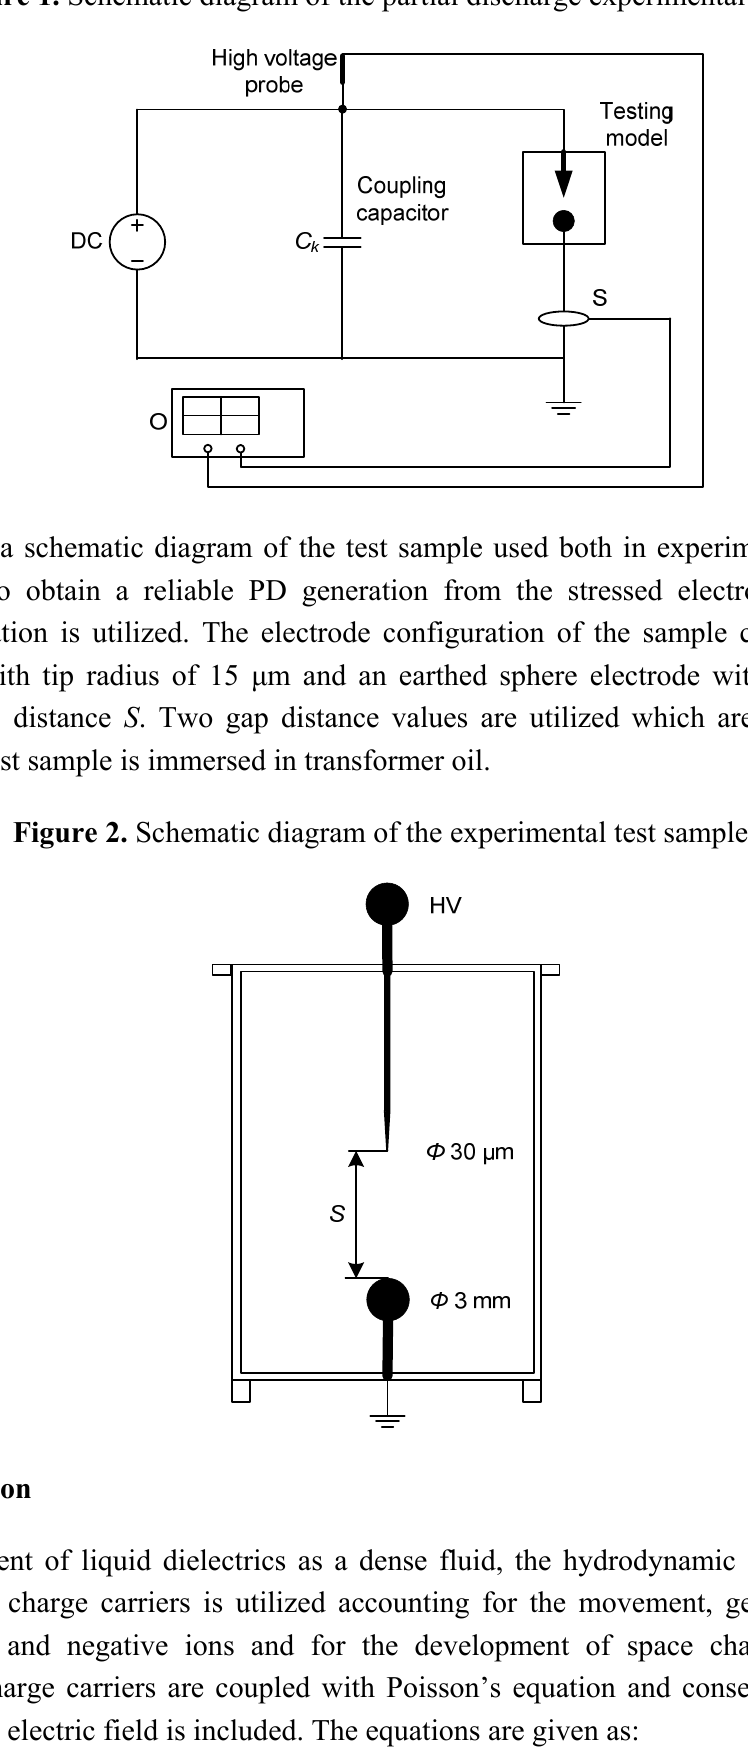
Figure 1. Schematic diagram of the partial discharge experimental setup.